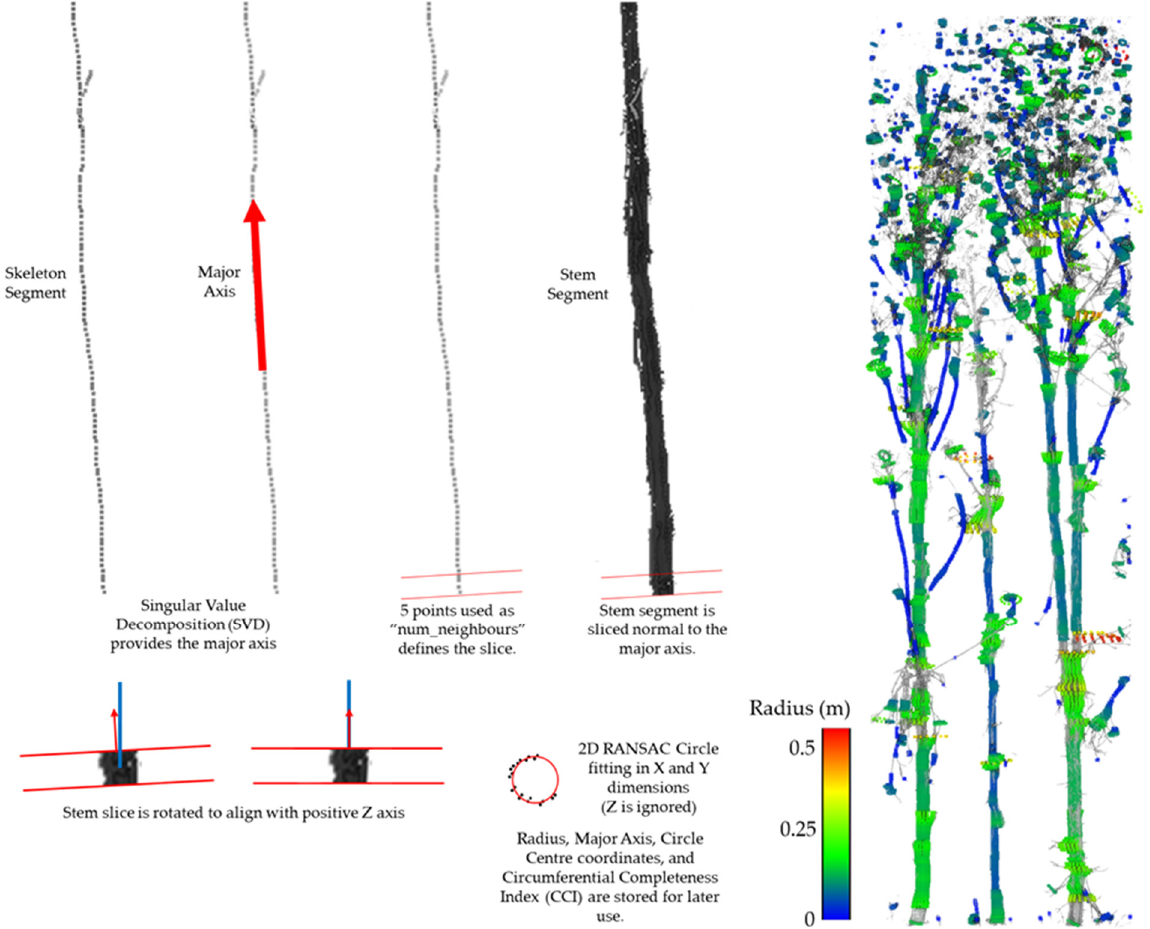
Figure 5. A visualisation of the circle fitting method. First, the major axis is identified from the skeleton segment, then the lowest point and its five nearest neighbours are identified. Two planes perpendicular to the major axis and on the boundaries of the selected six points are used to slice the stem segment. This slice is rotated to be vertical, allowing 2-dimensional random sample consensus (RANSAC) circle fitting to be performed to define the cylinder radius and centre coordinates. The result of this process is visualised on the right of the figure.